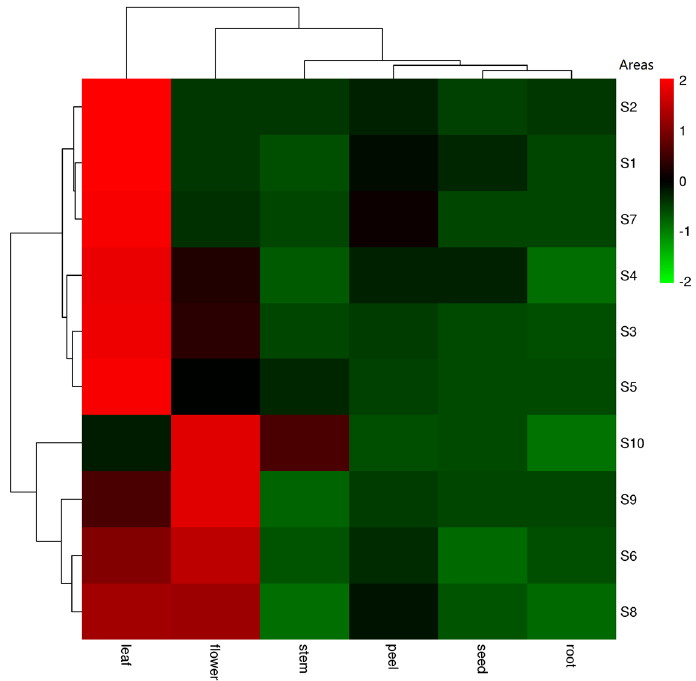
Figure 2. The heat-map of total withanolide content in each part of D. metel L.